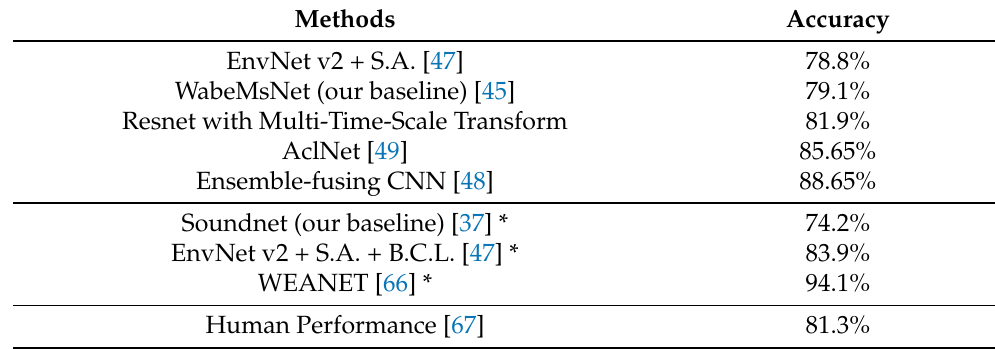
Table 3. ESC-50 dataset